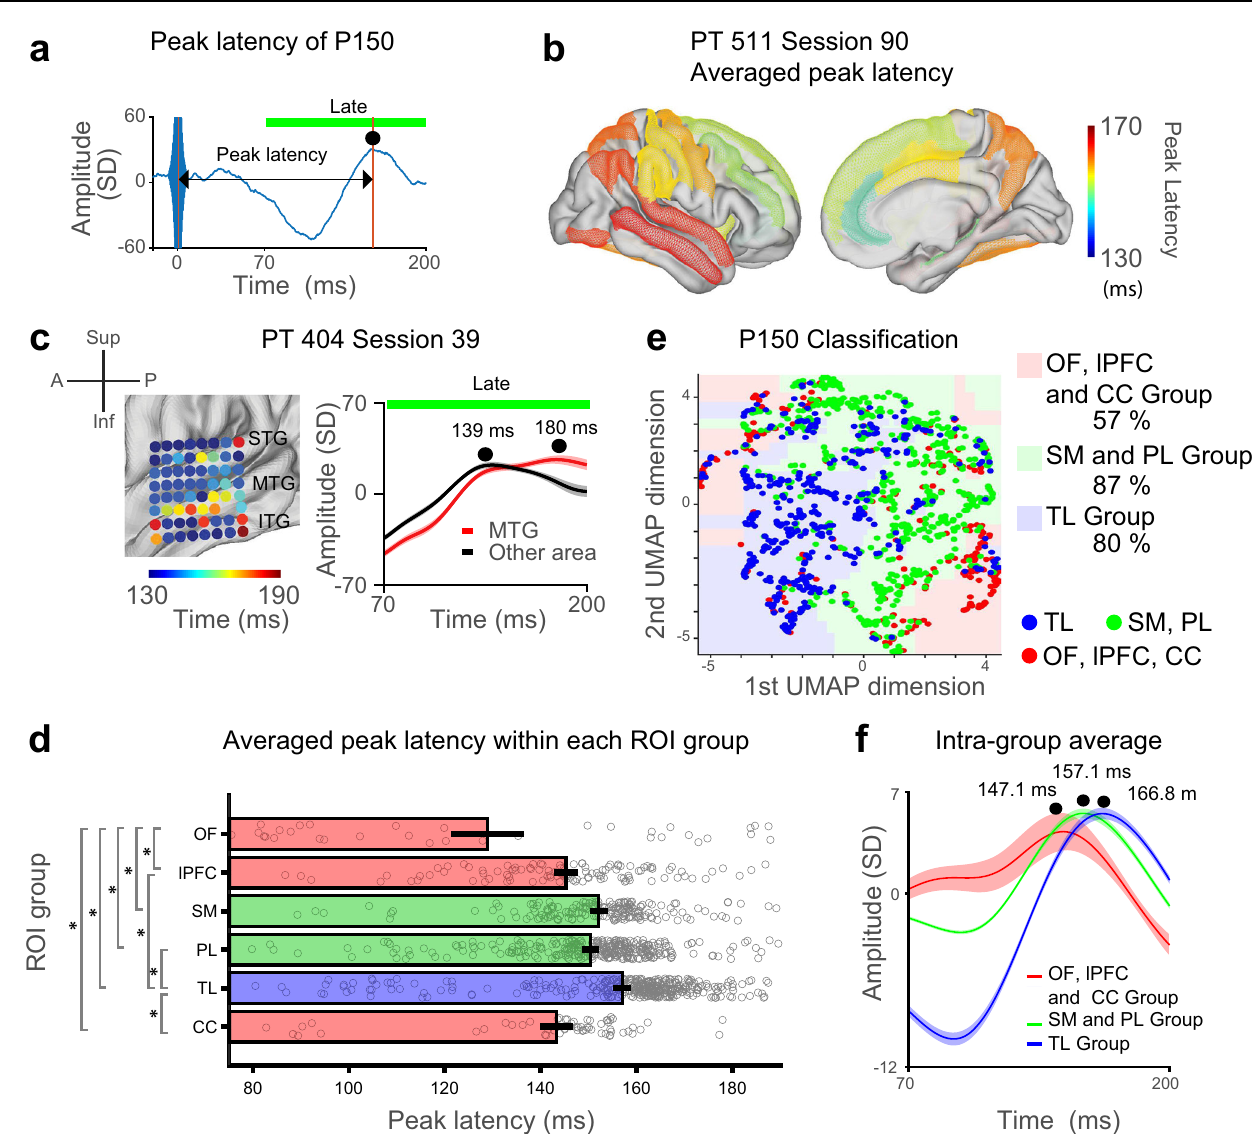
Fig. 5 | es-TT latency analysis for late time window (P150) in medial amygdala stimulation. a De fi nition and measurement of peak latencyof P150 component in the EPs. Green horizontal bars indicate late time window. Black dot indicates peak of P150 component. b Peak latency distribution in one patient (PT511) plotted on theMNIbrain.Colorrepresentspeaklatency. c Peaklatencydistributioninanother patient obtained with high-density grid. Right panel shows ROI averaged EPs time course. Black dots represent peak latency for MTG and other anatomical sites covered by the grid. Lines and shadings around them represent mean and SE. d Latencydistributionwithin6anatomicalgroups(sameasinFig.4c).MeanandSE (barsanderrorbars)areshowntogetherwitheachdatapointsrepresentedbygray circles. One-way ANOVA showed signi fi cant difference among groups, F(5,1032)=20.17, P =3.08×10 − 19 . Signi fi cant post hoc comparisons were indicated by asterisks on the vertical gray bars (Tukey ’ s tests, see main text for exact P - values). Number of EPs are 34, 110, 179, 310, 345, and 60 for OF, lPFC, SM, PL, TL,